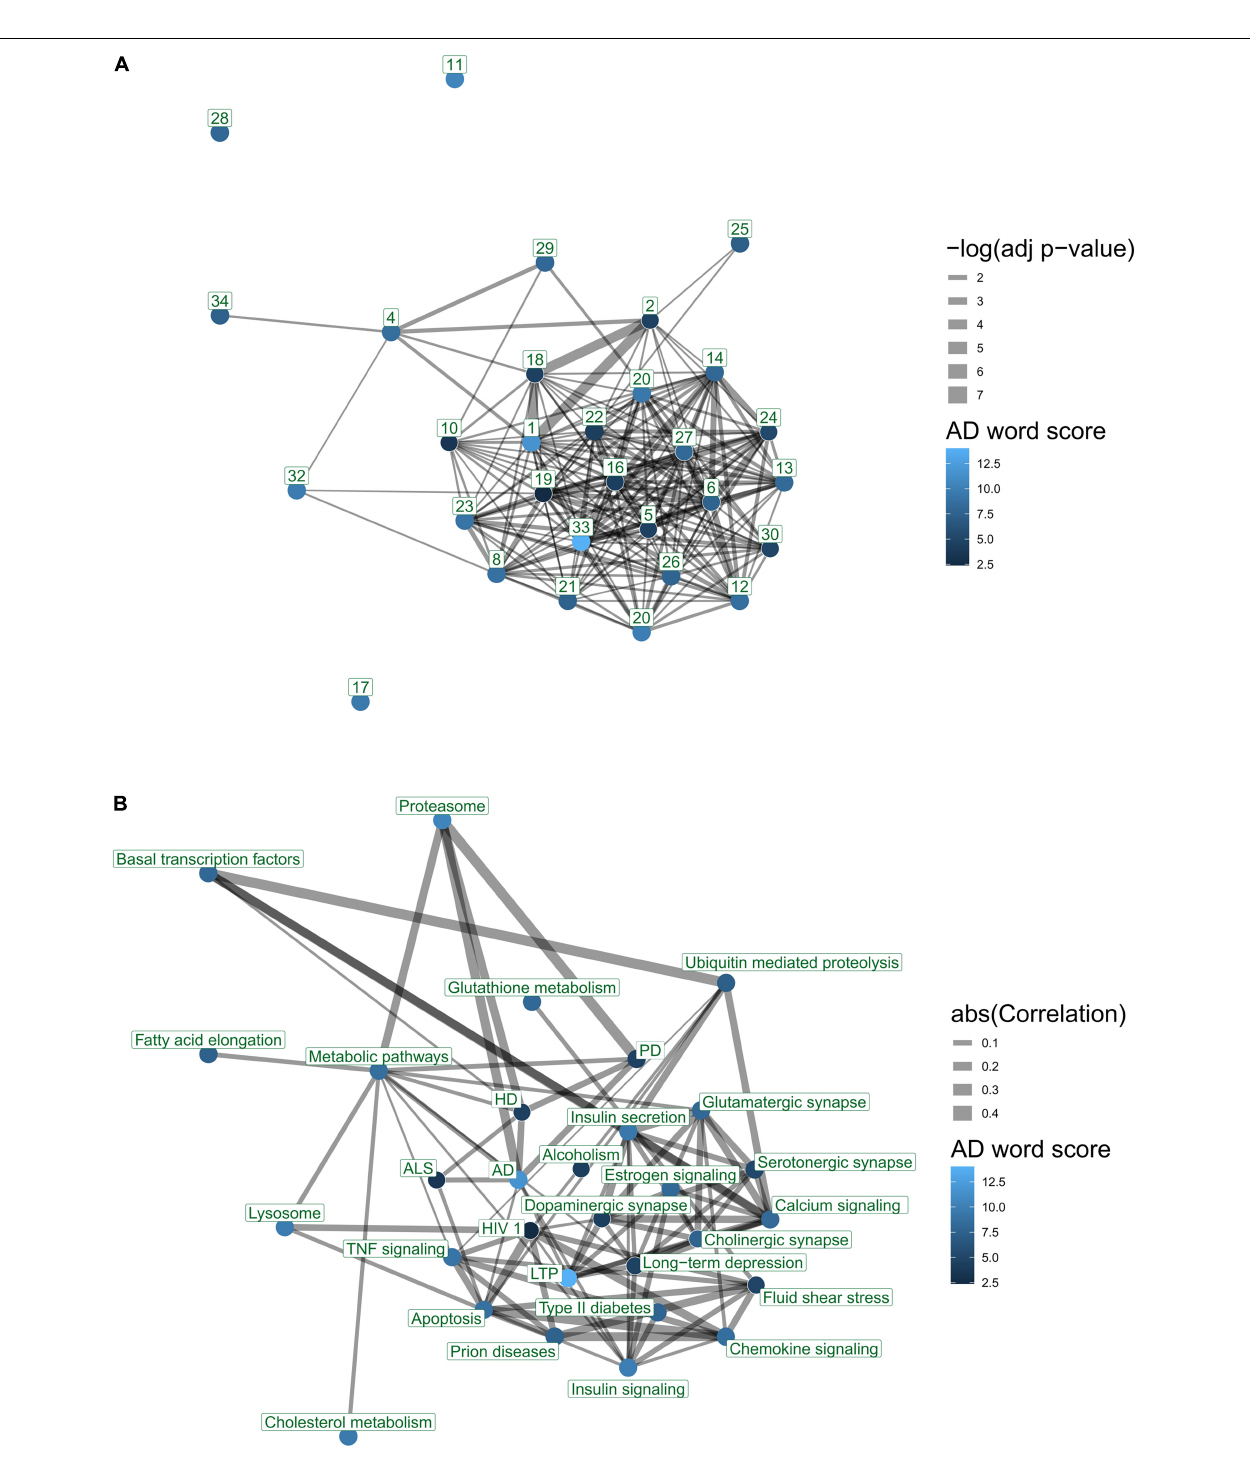
FIGURE 6 | Interaction networks of top 30 KEGG pathways according to text-mining. Nodes represent pathways. Node color indicates AD word score denoting average number of AD-related terms per paper, for each pathway. Edges reflect a significant association between two pathways. Edge thicknesses reflect the strength of association. (A) Gene overlap between pathways. Edges represent significant enrichment between pairs of pathways (FDR < 0.05). Node number indicates ranking in the literature. Edge thicknesses reflect significance (–log p -value) of enrichment. (B) Co-expression of pathways. Edges represent canonical correlations as defined by a pathway correlation analysis (PCxN) (Pita-Juárez et al., 2018). Edge thickness values represent the absolute value of correlation between the two pathways. The figure was generated using the igraph package. The nodes were placed in the two-dimensional coordinates using a forced layout algorithm for the gene overlap network. The co-expression network was aligned to the same layout as the gene overlap network.